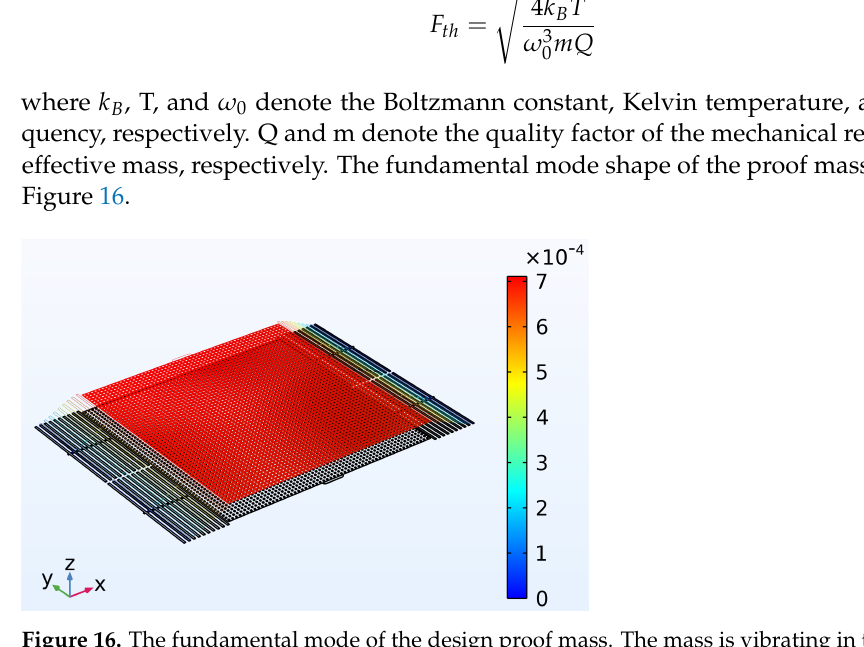
Figure 16. The fundamental mode of the design proof mass. The mass is vibrating in the z -direction only and the color bar presents the displacement in